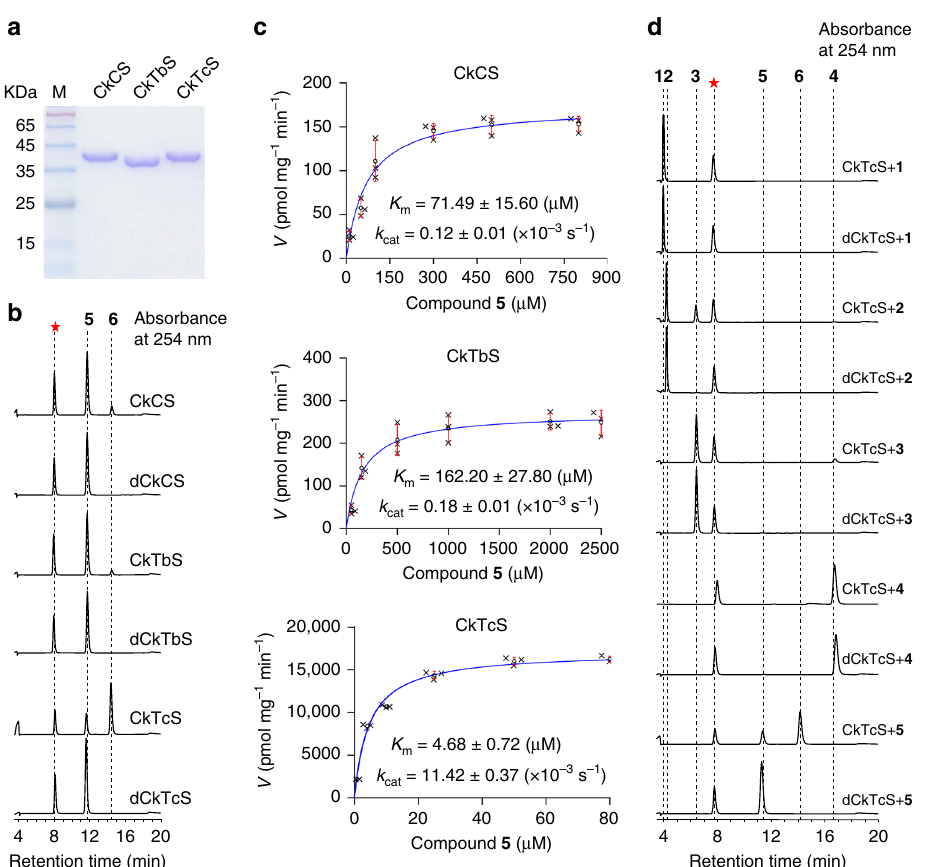
Fig. 2 Identi fi cation of N 9-methyltransferase involved in converting caffeine into theacrine in tea leaves. a SDS-PAGE analysis of the recombinant CkCS, CkTbS, and CkTcS proteins. b In vitro N 9-methyltransferase activity analysis of CkCS, CkTbS and CkTcS. HPLC analysis of in vitro reaction products using 1,3,7-trimethyluric acid ( 5 ) as a substrate with CkCS and denatured CkCS (dCkCS), CkTbS and denatured CkTbS (dCkTbS), CkTcS and denatured CkTcS (dCkTcS). The absorbance wavelength was set at 254 nm. c Steady state kinetic analysis of CkCS, CkTbS, and CkTcS using 1,3,7-trimethyluric acid ( 5 ) as a substrate. Initial velocities are shown as cycles and represented as mean ± SD ( n = 3). The corresponding dot plots are overlaid on the fi gure. The blue line represents the nonlinear least-squares fi t of the initial velocities versus 1,3,7-trimethyluric acid concentration to the hyperbolic Michaelis-Menten equation. Kinetic parameters were determined at a saturating concentration of 1.5 mM SAM. d In vitro N -methyltransferase activity of CkTcS and dCkTcS towards xanthosine ( 1 ), 7-methylxanthine ( 2 ), theobromine ( 3 ), caffeine ( 4 ), and 1,3,7-trimethyluric acid ( 5 ). The absorbance wavelength was set at 254 nm. In all HPLC chromatograms, a red asterisk indicates an impurity compound from the SAM reagent.